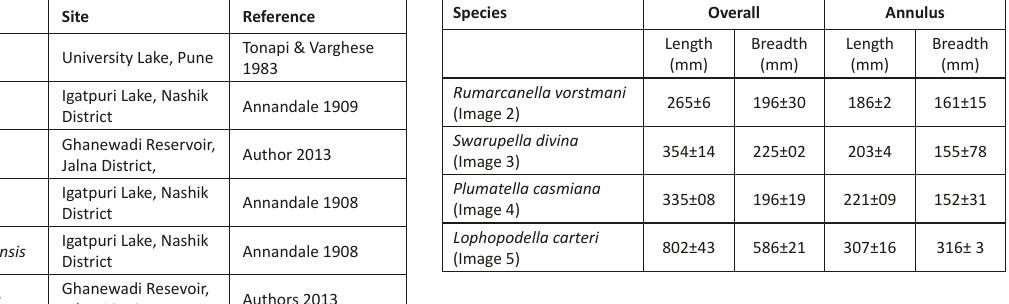
Table 1. Complete record of freshwater bryozoans from Maharashtra State Species